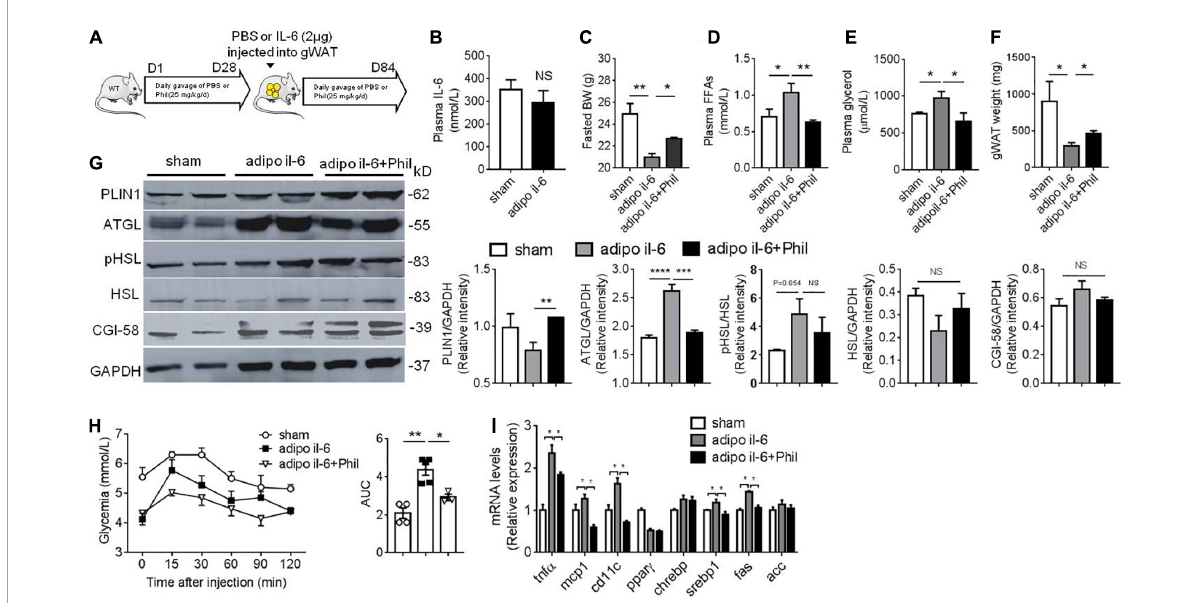
FIGURE5 Phillyrin attenuates adipose IL-6-associated basal lipolysis and hepatic dysfunctions. (A) Protocol of IL-6 injection into WAT in vivo . WT mice previously treated with or without Phillyrin (i.g. 25 mg/kg/d) for 28 days, received IL-6 injection into gWAT (1 µ g per depot per mouse) and after that Phillyrin treatment continued for another 56 days. Sham mice also surgically received PBS injection into gWAT. (B) Plasma level of IL-6 of sham and adipo il-6 mice. N = 6 per group. (C) Body weight of sham mice or adipo IL-6 mice treated with vehicle or Phillyrin. N = 4–7 per group. (D) Plasma FFA level, (E) plasma glycerol level, and (F) total gWAT weight in mice. N = 4–7 per group. (G) Western blot analysis of lipolytic proteins expression and HSL phosphorylation at Ser 563 in gWAT of mice. N = 4 per group. (H) Pyruvate tolerance test and AUC of different groups. N = 4–7 per group. (I) Expression of inflammation and lipid metabolism related genes in the livers of mice. N = 3–4 per group. All data in the figures are shown as mean ± SEM. * P < 0.05, ** P < 0.01, *** P < 0.005, and **** P <